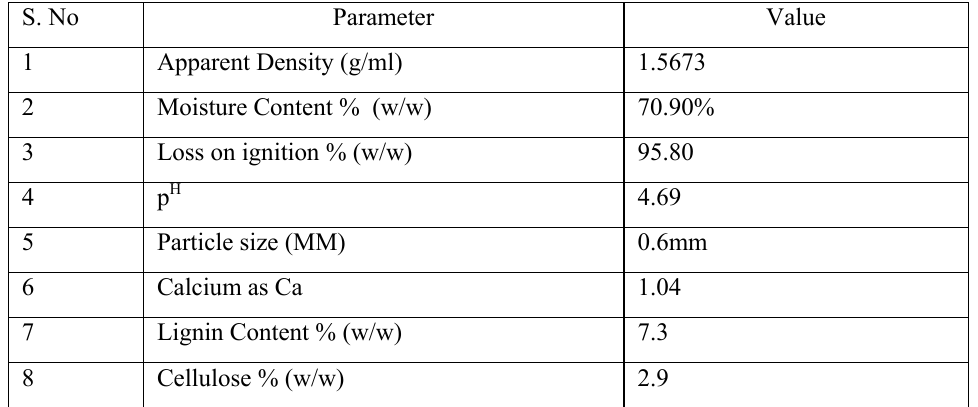
Table 2. Characteristics of